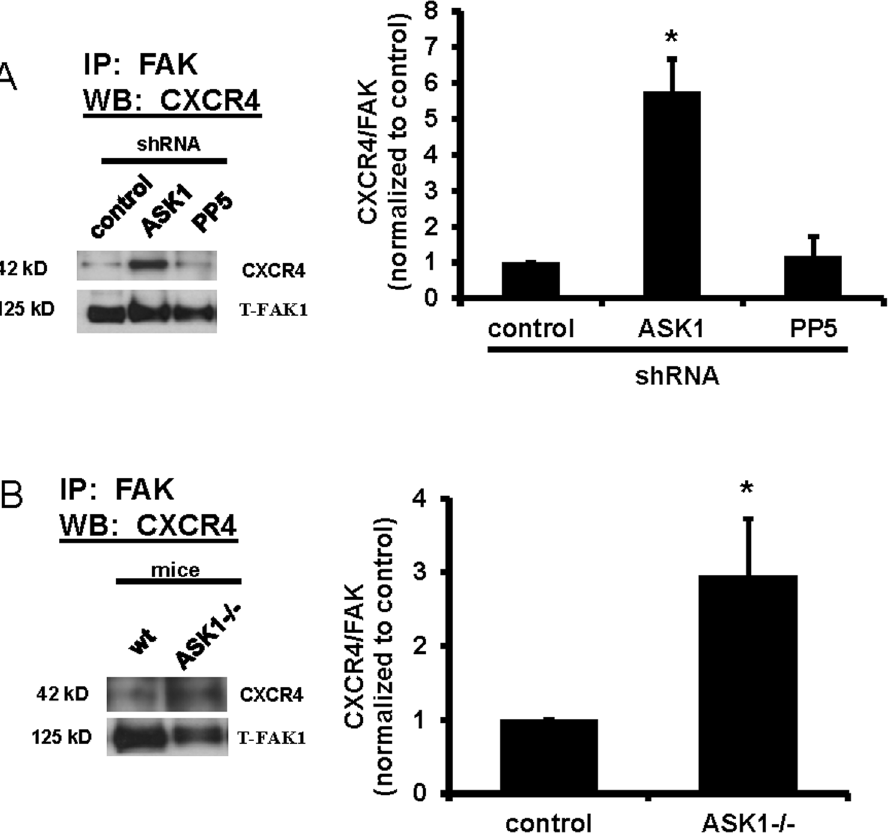
Figure 3. CXCR4 interactions with FAK were inhibited by ASK1. Panel A Cell lysates were collected from MLE-12 cells with control shRNA, ASK1-shRNA, or PP5-shRNA, immunoprecipitated with a FAK antibody, and immunoblotted for CXCR4 or FAK. Decreased expression of ASK1 caused a significant increase in CXCR4 associated with FAK as indicated by densitometry analysis (right panel), but decreased expression of PP5 did not affect the interaction (n = 3). Panel B CXCR4 interaction with FAK was significantly increased in cell lysates from ATII cells from ASK1 − / − mice compared with cells from wild type (wt) mice (n = 5). Asterisks ( * ) indicate a significant difference compared to control (control-shRNA or wild type); p < 0.05. Total FAK was immunoblotted as a loading control. Each set of bands shown was cropped from the same blot, and the full- length blots were provided in supplemental